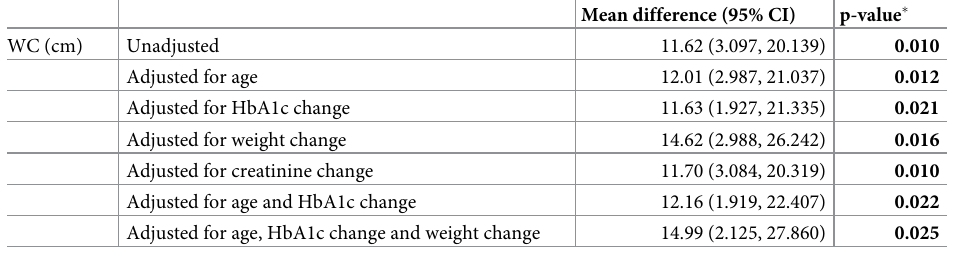
Table 4. Repeated measures ANCOVA (group � time-effect) comparing waist circumference between two different groups based on time (N =